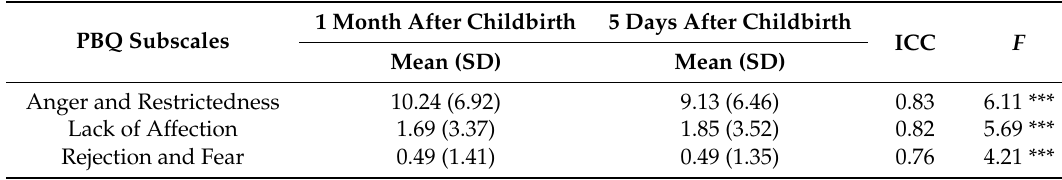
Table 3. Test–retest reliability of the PBQ factors (Intraclass Correlation Coefficient; ICC).